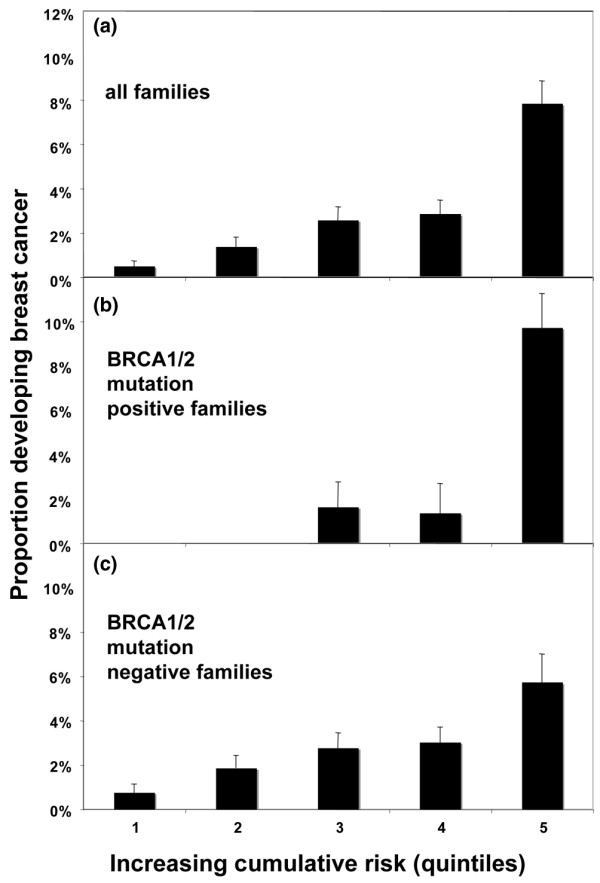
Relationship between estimated cumulative probability and actual relative frequency of breast cancer since ascertainment. Women unaffected at time of interview were ranked in quintiles according to their cumulative risk of breast cancer since interview, calculated from the absolute risk estimated by a batch program implementing the Tyrer-Cuzick algorithm. The proportion of women in each risk quintile (horizontal axis: 1 lowest to 5 highest) developing breast cancer during a median 4.2 years follow-up is plotted on the vertical axis plus standard error. (a) All families; (b) BRCA1 or BRCA2 mutation positive families; (c) BRCA1 or BRCA2 mutation negative families.